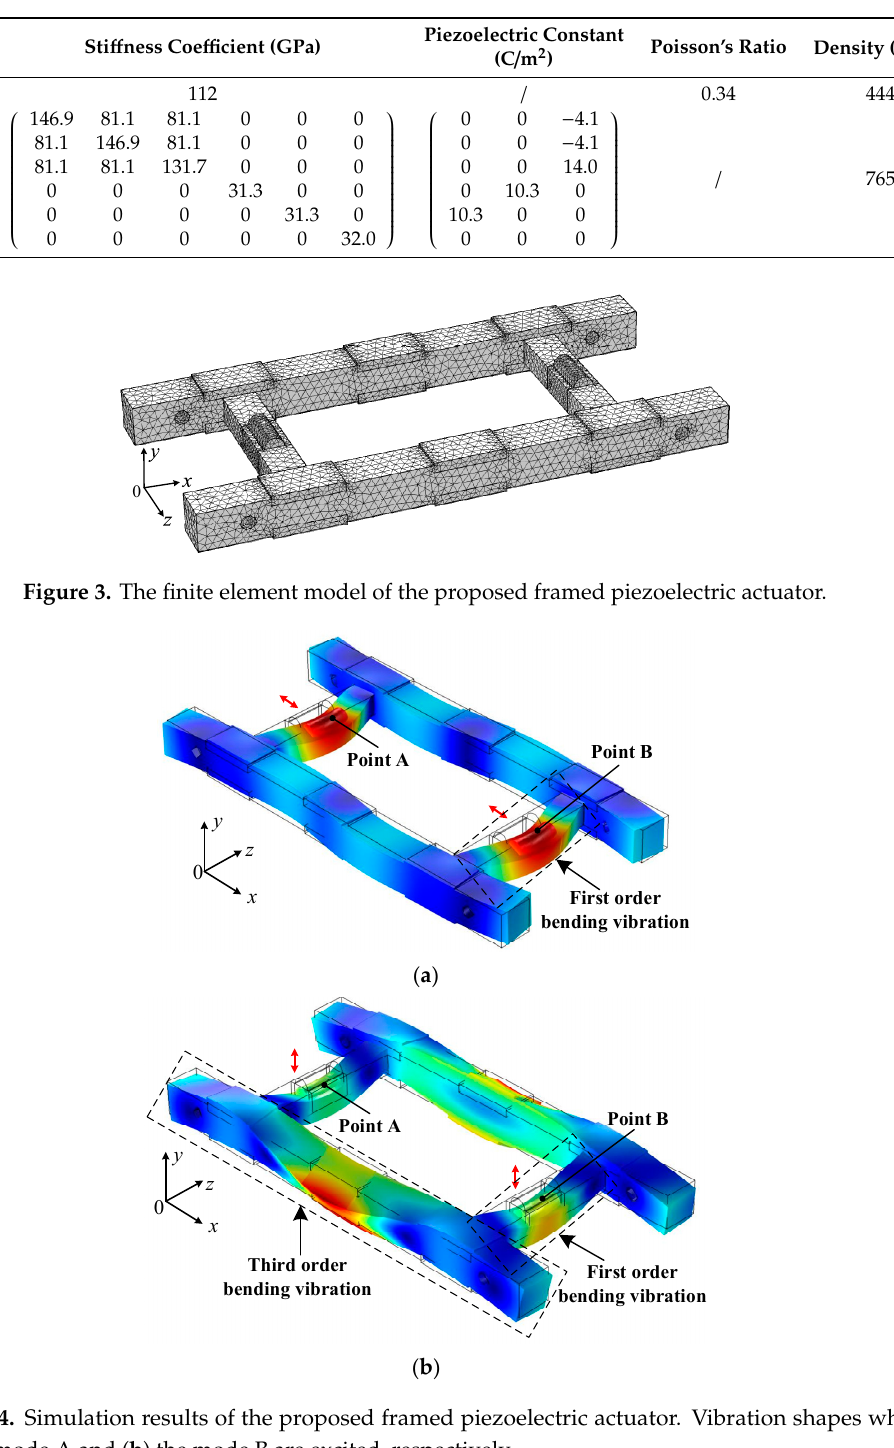
Table 1. Material parameters of the framed piezoelectric actuator.